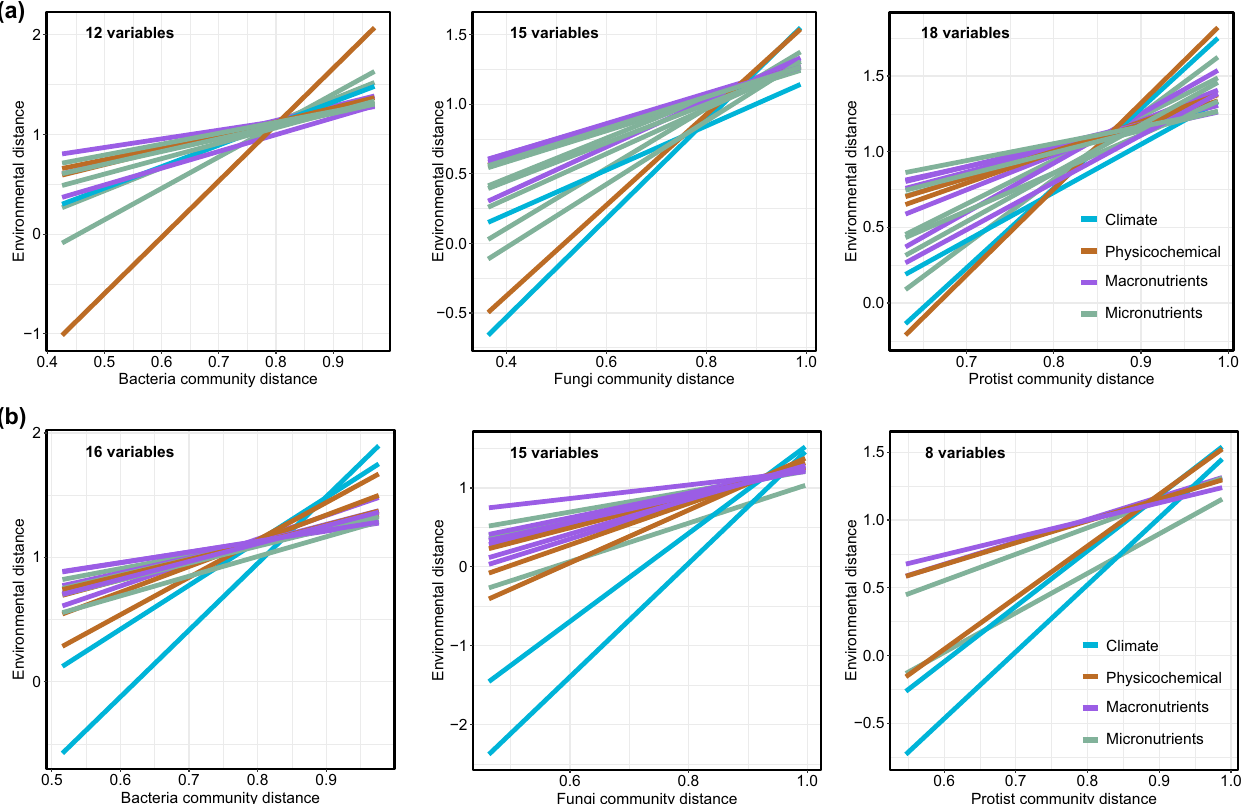
Fig. 2 Relationships between soil bacterial, fungal, protistan communities and environmental distance in maize and paddy soils. a maize soils, ( b ), paddy soils. Differences among environment and communities were estimated using mantel test base on Bray – Curtis distances. Lines represent fi tted linear regressions between environmental distance and associated bacterial, fungal or protistan communities. Only environmental factors with signi fi cant relationship with the communities are shown in fi gure (the number in the upper left). A full version of this fi gure showing each environmental factor can be found in Supplementary Figs. 2 – 7 and Supplementary Tables 2 –